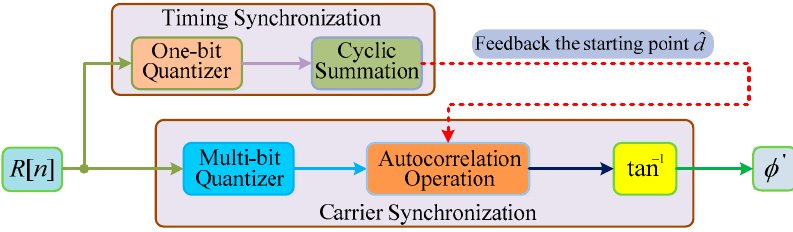
Figure 4. Synchronization framework with low-resolution analog-to-digital converters (ADCs).